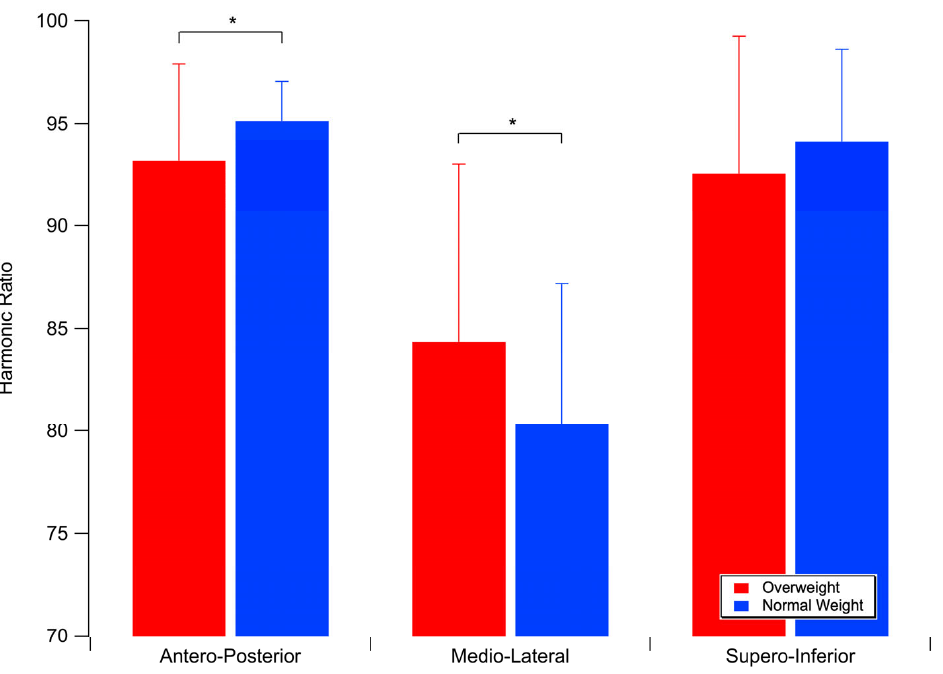
Figure 1. Trend of HR for normal-weight and overweight children. Values are displayed as mean and SD. The symbol * denotes a significant difference vs. normal-weight children after Bonferroni correction ( p = 0.016).